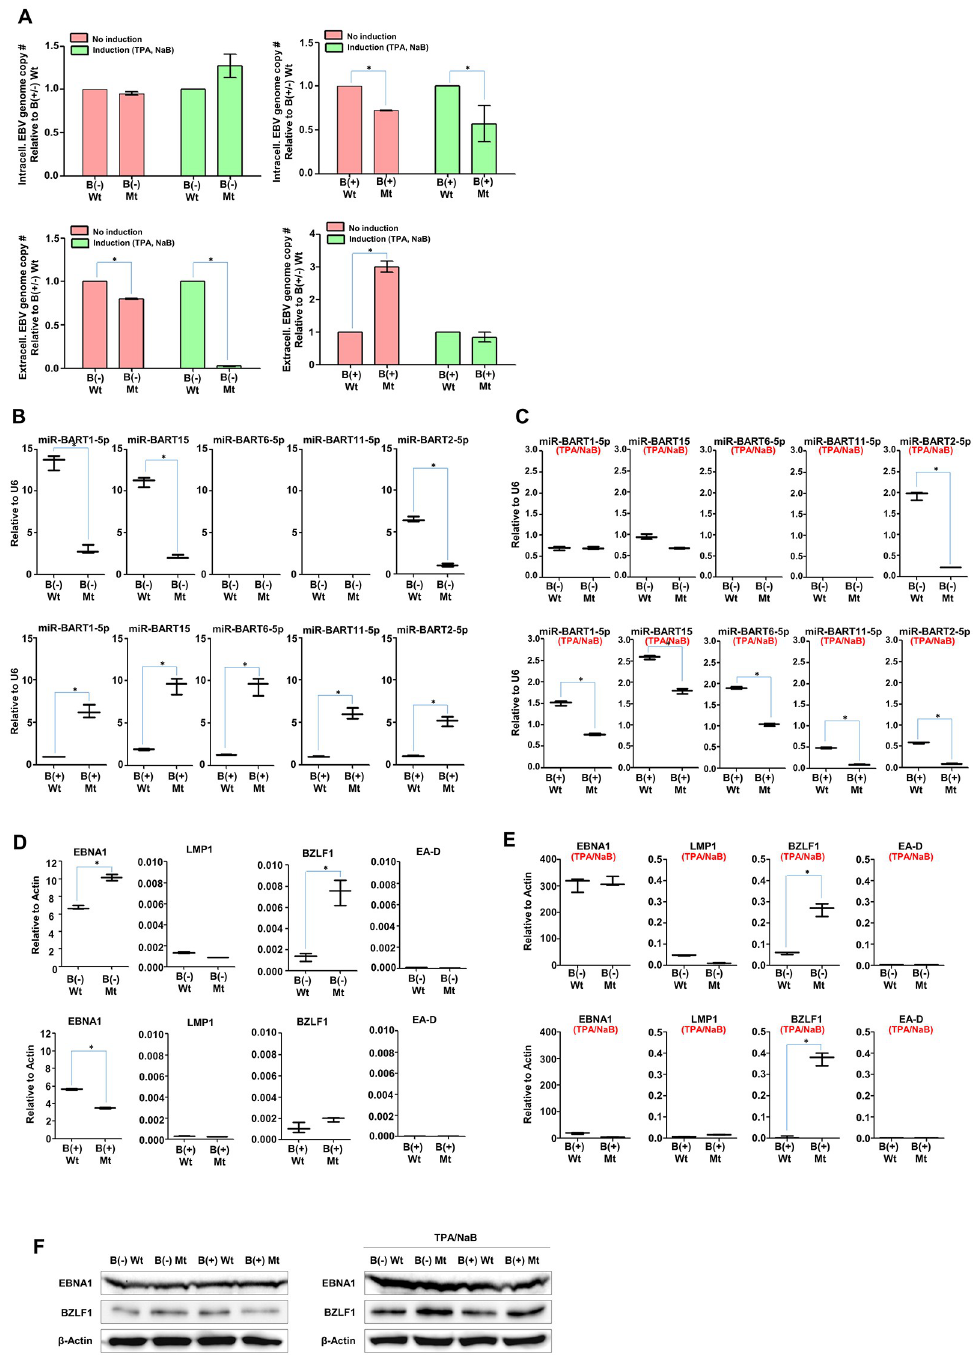
Fig 6. Regulatory role of S13 CTCF binding site on EBV gene expression. A) Relative quantification of relative intracellular and extracellular EBV genome copy numbers. qPCR assay with EBNA1 primer set (EBV 96778–96979, EBV 96827–96845) was conducted to measure EBV genome copy numbers in all four types of HEK293-EBV cells which were either uninduced or induced with TPA and NaB. B(-)Wt, B(-)Mt, B(+)Wt, and B(+)Mt stand for HEK293-EBV cells of BART(-) � S13 + , BART(-) � S13 - , BART(+) � S13 + , BART(+) � S13 - , respectively. Absolute intracellular and extracellular EBV genome copy numbers were Both absolute intracellular and extracellular EBV genome copy numbers were evaluated by EBNA1 Ct values. Relation equation between absolute DNA amounts and EBNA1 Ct values was first defined and then applied to calculate DNA concentration ( μ g/ μ L) per length of template (bp) using a website called Copy Number Calculator of Technology NetWorks (https://www.technologynetworks.com/tn/tools/copynumbercalculator).